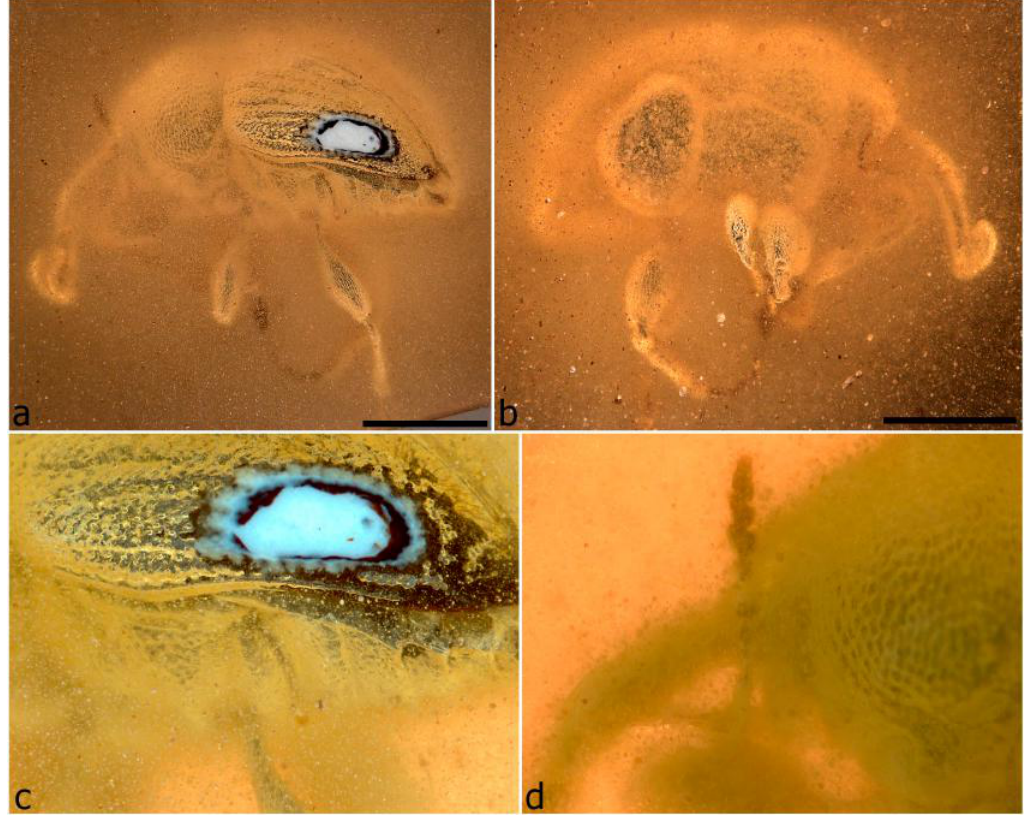
Figure 53. Gnomus brevis sp. n., holotype. Habitus, left lateral ( a ); habitus, right lateral ( b ); left elytron, left lateral ( c ); head, antenna and eye, left lateral ( d ). Scale bars: 1.0 mm (a,b).